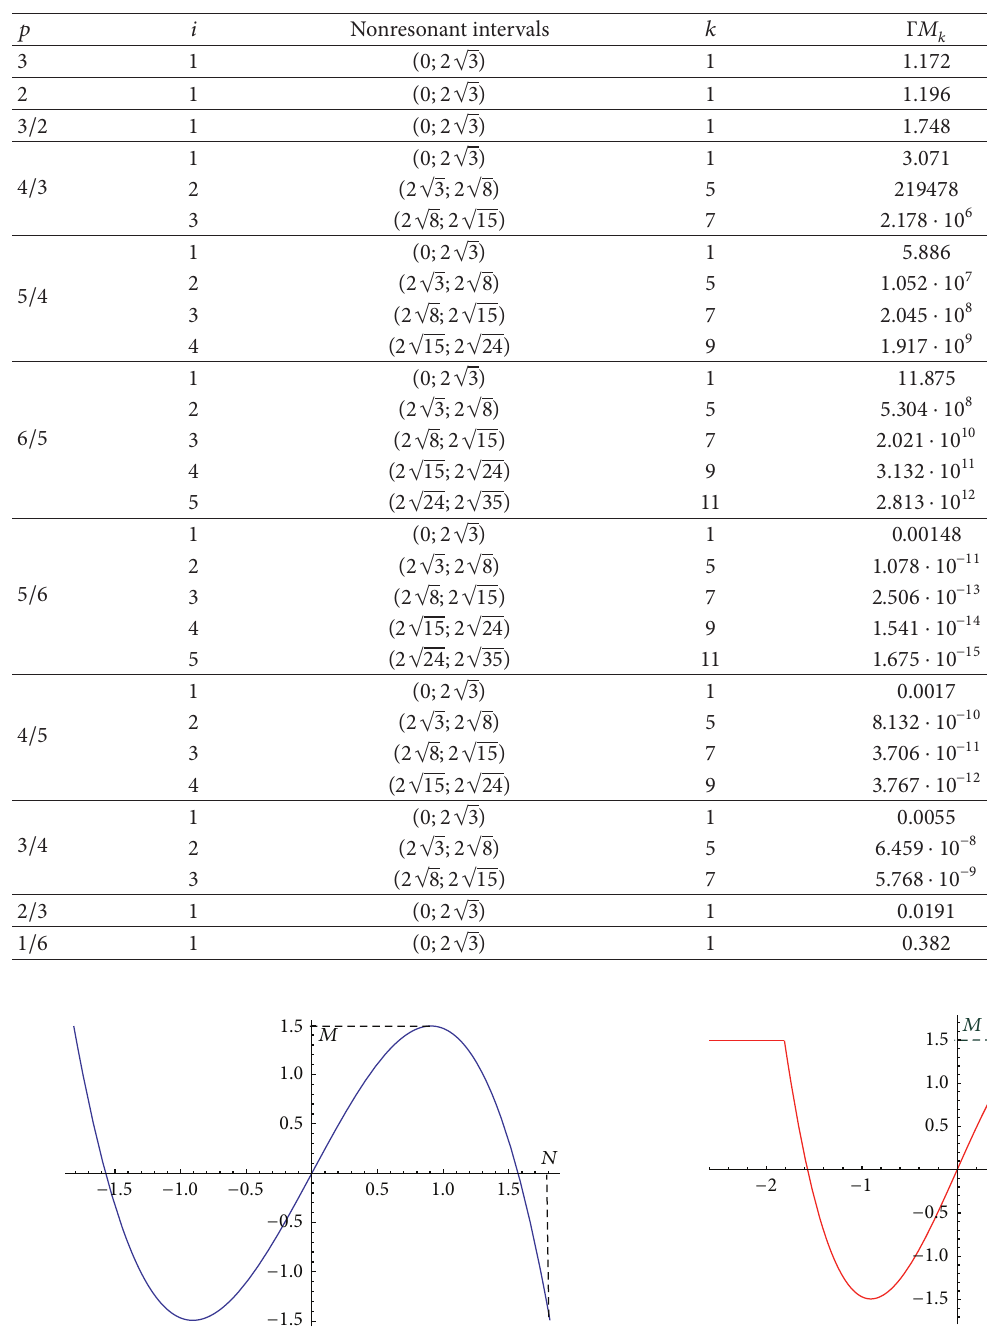
Table 1: Results of calculations for the boundary value problem 𝑥 󸀠󸀠 + 𝜋 2 𝑥 = −|𝑥| 𝑝 sign 𝑥 , 𝑥(0) = 0 = 𝑥(1) .